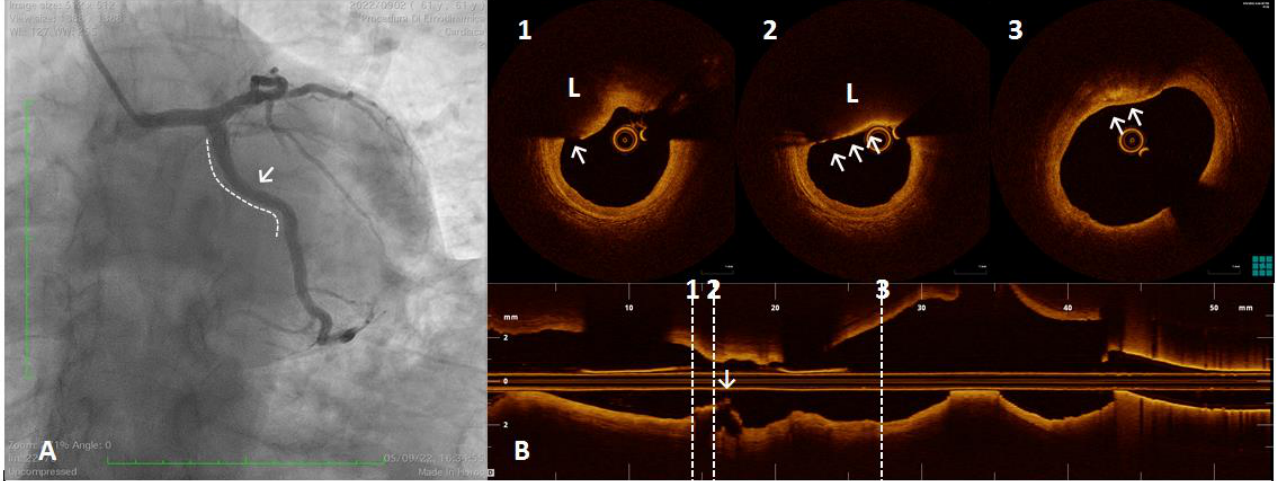
Figure 5. A 61 year old man referred for Non-ST-segment elevation myocardial infarction (NSTEMI). Coronary angiography showed no significant coronary lesions. Left circumflex showed haziness at the proximal segment (panel ( A ), white arrow). The OCT pull-back showed a fractured plaque (panel ( B ), 1, white arrow) associated with a lipid pool (panel ( B ), 1 and 2, “L”); thin-cap fibro-atheroma and active macrophages are easily detected because of their typical bright line (2, white arrows) or spot images, within a fibro-lipidic plaque (3, white arrows).